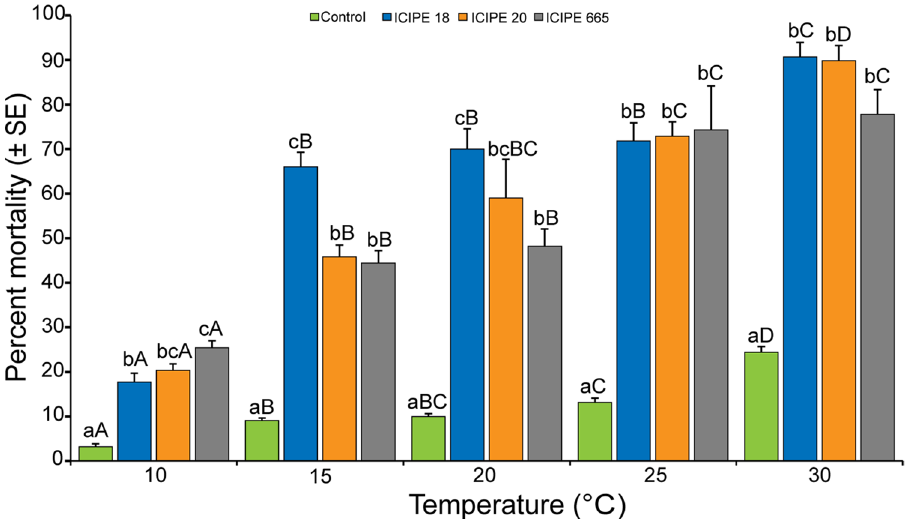
Figure 4. Effect of temperatures on virulence of the three isolates of Metarhizium anisopliae against adult Tuta absoluta , 12 days post-inoculation. Different lowercase letters show significant difference (GLM, P ≤ 0.05) in mortality among fungal isolates across the different temperature regimes. Different uppercase letters denote significant difference (GLM, P ≤ 0.05) in mortality across the different temperature regimes for each isolate (n = 60; N = 4; Tukey’s HSD test).